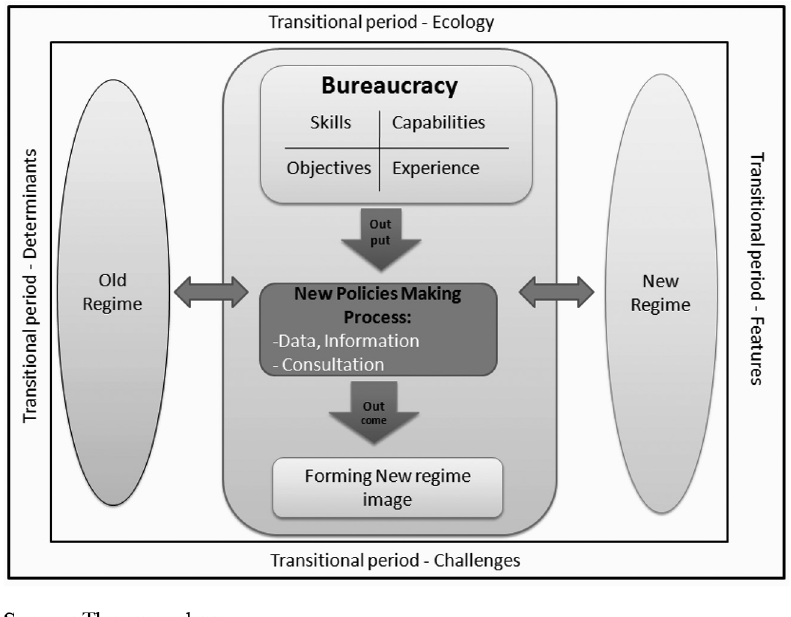
Figure 1. The ecology of transitional